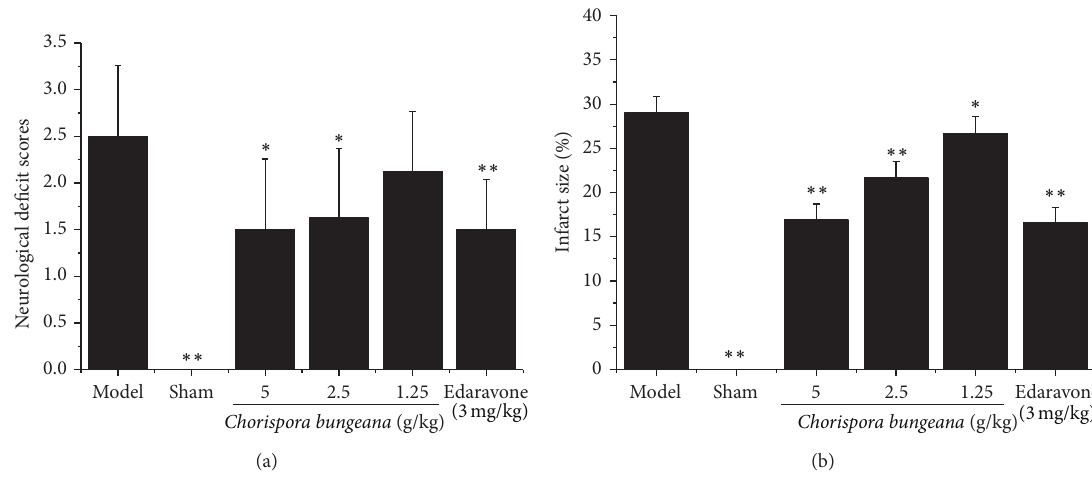
Figure 1: Effect of Chorispora bungeana water extract on neurological deficit scores (a) and infarct size (b) in mice subjected to cerebral ischemia/reperfusion. Data were expressed as mean ± S.M.E. Differences were considered significant at 𝑃 < 0.05 . ∗ 𝑃 < 0.05 versus model group. ∗∗ 𝑃 < 0.01 versus model